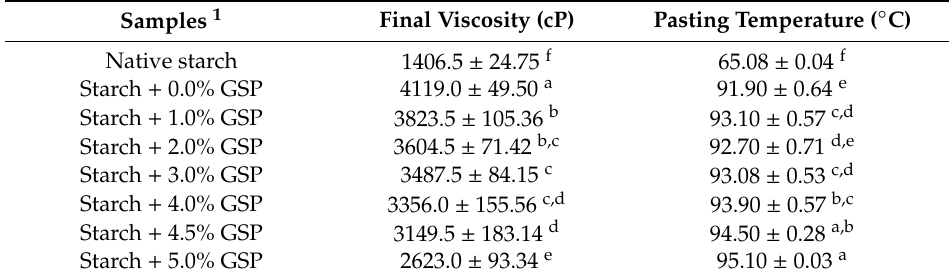
Figure 2. Pasting properties of native starch and GSP–potato starch complexes with di ff erent binding amounts of GSP. Table 2. Pasting parameters: pasting temperature ( ◦ C) and final viscosity (cP) for native potato starch and GSP-potato starch